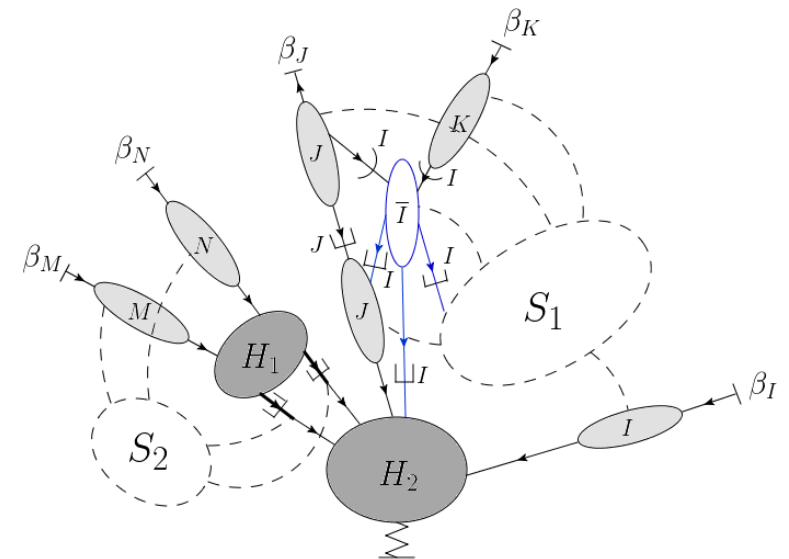
Figure 11. A general picture of the pinch surfaces of t (cid:27) A , which contains all the con(cid:12)gurations in table 1. There are (cid:12)ve external jet momenta in total, separately in the directions of (cid:12) (cid:22) (cid:12) (cid:22) and (cid:12) (cid:22) . The blob and lines marked blue are in the direction of (cid:12) M N between each jet and H (or H ); case (Bii) occurs where the propagators collinear to (cid:12) (cid:22) 1 2 (cid:22) (cid:12) (cid:22) (cid:13)ow into the blob in the direction of (cid:12) ; case (Biv) occurs where the soft propagators I K of S is attached to the blob in the (cid:12) -direction. Cases (Ci), (Cii) and (Ciii) separately 1 I occurs at the connections between the propagators collinear to (cid:12) approximation hc ( (cid:27) ) , and other subgraphs: H , the blob in the direction of (cid:12) (cid:22) 2 I Finally, the hard-exotic con(cid:12)guration in case (D) occurs at the vertices where H S ; the remaining case in case (D) can occur inside the hard subgraphs H 2